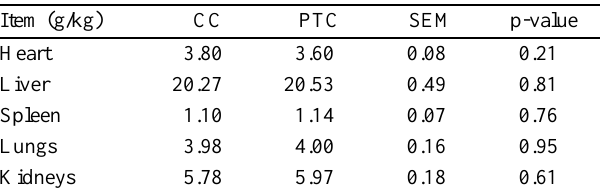
Table 2. Serum chemistry values of laying hens fed diets containing conventional corn (CC) or phytase transgenic corn (PTC) for 16 weeks